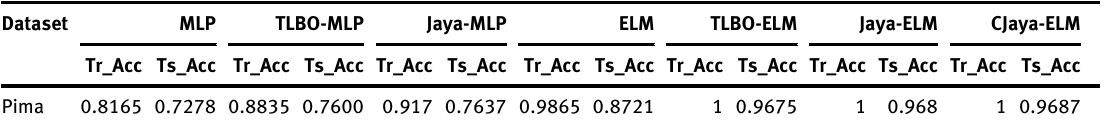
Table  : Maximum training (Tr_Acc) and testing (Ts_Acc) accuracies of MLP, TLBO-MLP, Jaya-MLP, ELM, TLBO-ELM, Jaya-ELM and CJaya-ELM.